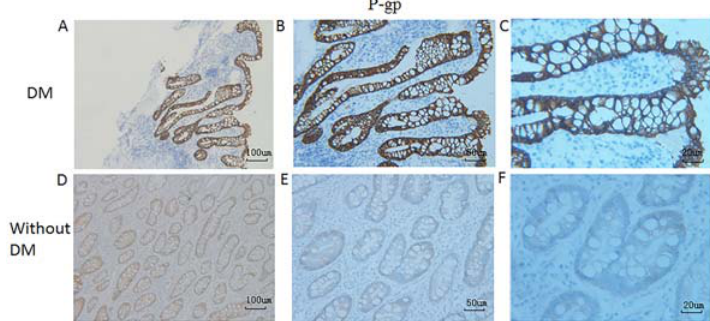
Figure 2. Immunohistochemical staining of P-glycoprotein (P-gp) in duodenum tissues of patients with pancreatic cancer with ( A , B , and C ) or without ( D , E , and F ) diabetes mellitus (DM). Representative images are shown. Magni fi cation 100 (cid:1) ( A and D , scale bar 100 m m), 200 (cid:1) ( B and E , scale bar 50 m m), or 400 (cid:1) ( C and F , scale bar 20 m m).